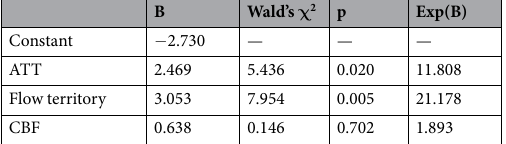
Table 3. Binary logistic regression analysis of 42 asymptomatic ICA steno-occlusive patients. Three dichotomous predictors were included (ATT, flow territory, and CBF): 1 = asymmetry and 0 = no discernable asymmetry. Hosmer-Lemeshow test yielded a χ 2 (3) of 0.792 and was insignificant (p = 0.851), suggesting that the model fit the data